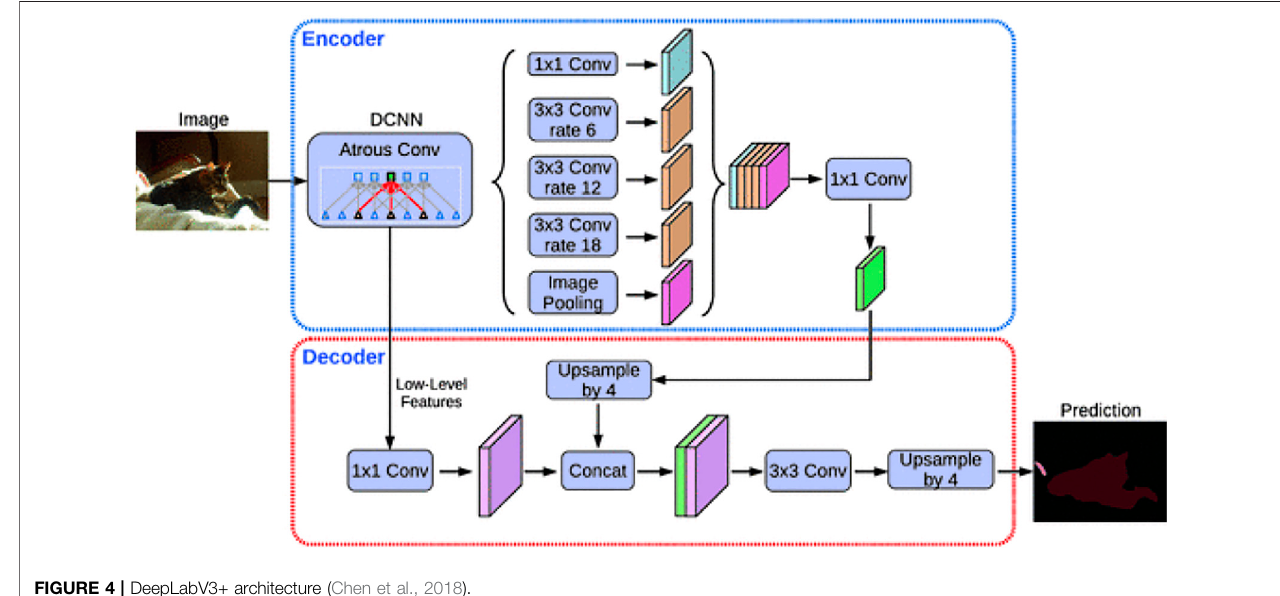
FIGURE 4 | DeepLabV3+ architecture (Chen et al., 2018).